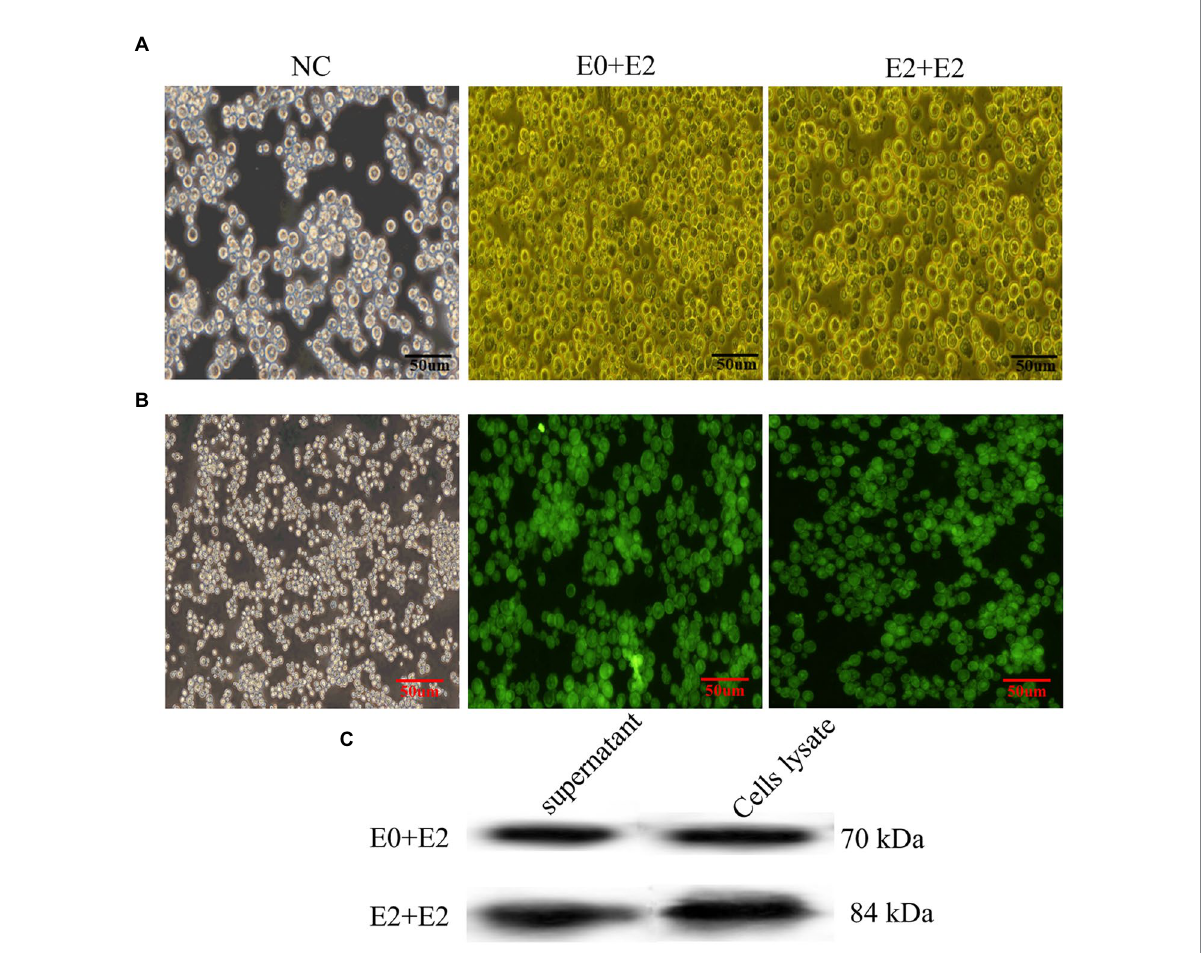
FIGURE 1 Expression of E0 + E2 and E2 + E2 proteins in Sf9 cells. (A) Sf9 cells infected with or without rescued recombinant viruses (rBacmids-E0 + E2 or rBacmids-E2 + E2). NC, Normal Sf9 cells. (B,C) Expression of exogenous genes by recombinant baculoviruses identified by IFA and western blotting (C) . His-tag antibody (dilution, 1:2,000) as the primary antibody, and HRP-conjugated goat anti-mouse IgG (dilution, 1:5,000) as the secondary